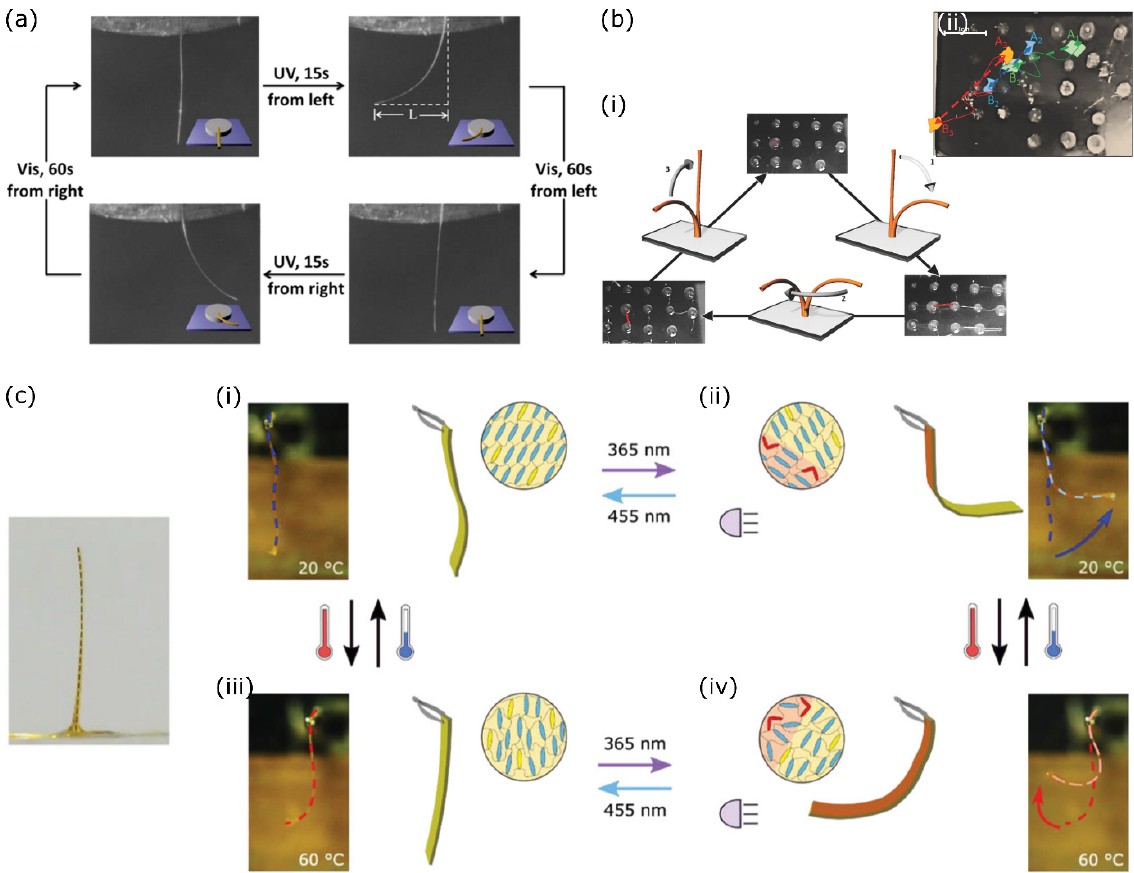
Figure 5. ( a ) Photoactuation of a heated and supramolecularly crosslinked LC fibre, illuminated from two directions with UV light. The fibre bends towards the UV light source regardless of direction and reverts to its straight orientation by visible light illumination. Adapted with permission from ref [36]. Copyright 2013 American Chemical Society. ( b ) Array of artificial LCE cilia that ( i )